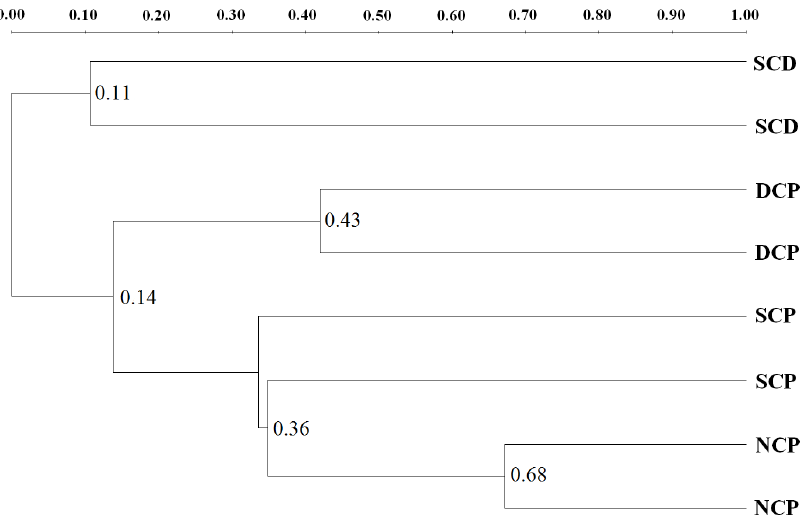
Figure 3. Cluster analysis of forest types by soil fungal community.